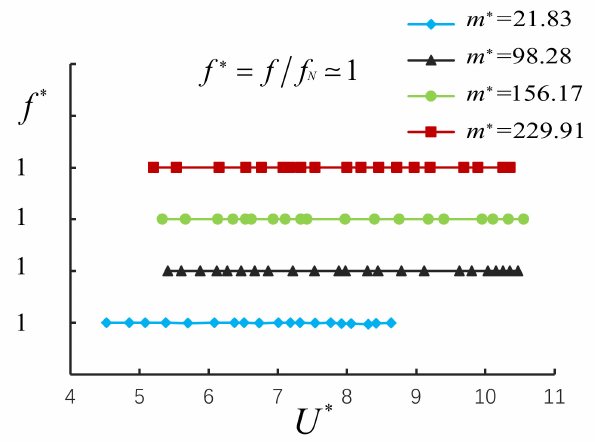
Figure 10. f ∗ with the change of U ∗ of experiment